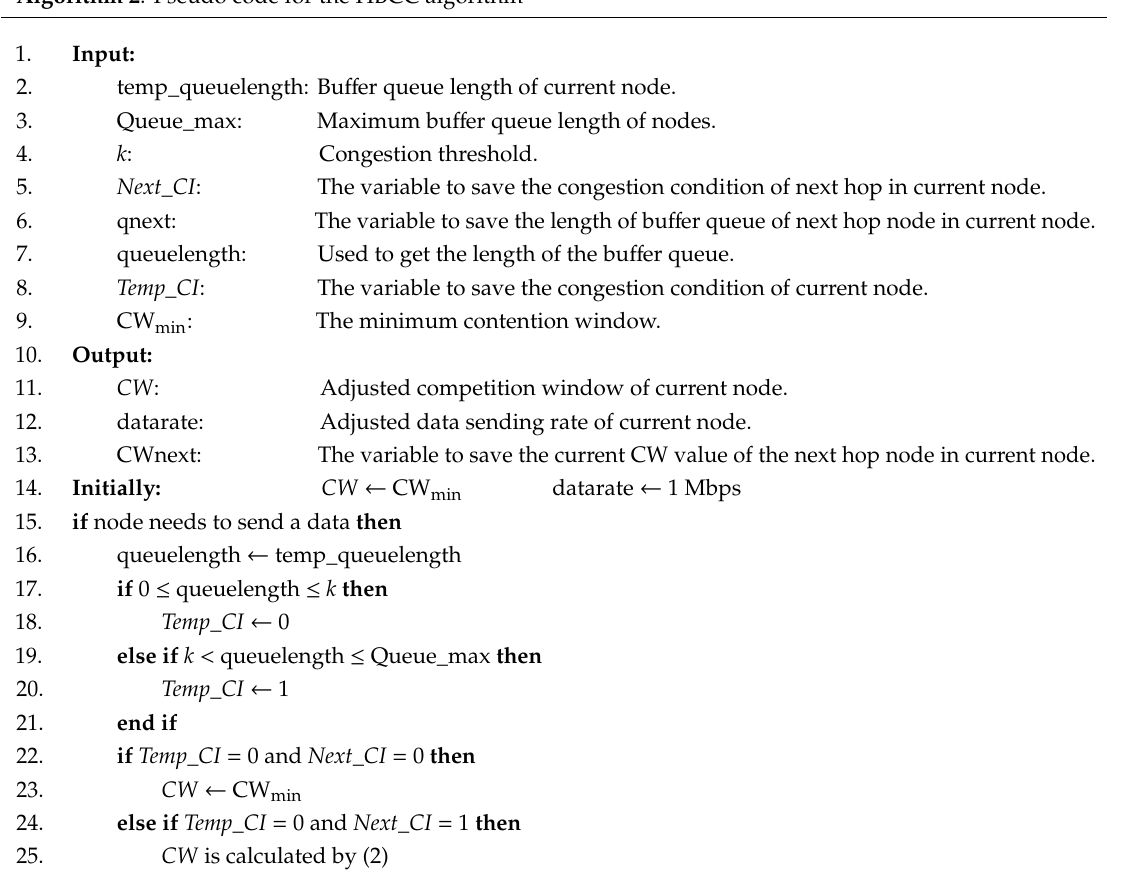
Algorithm 2 : Pseudo code for the HBCC